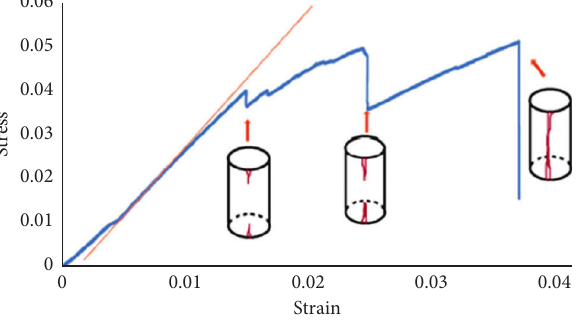
Figure 3: Splitting tensile stress vs. strain